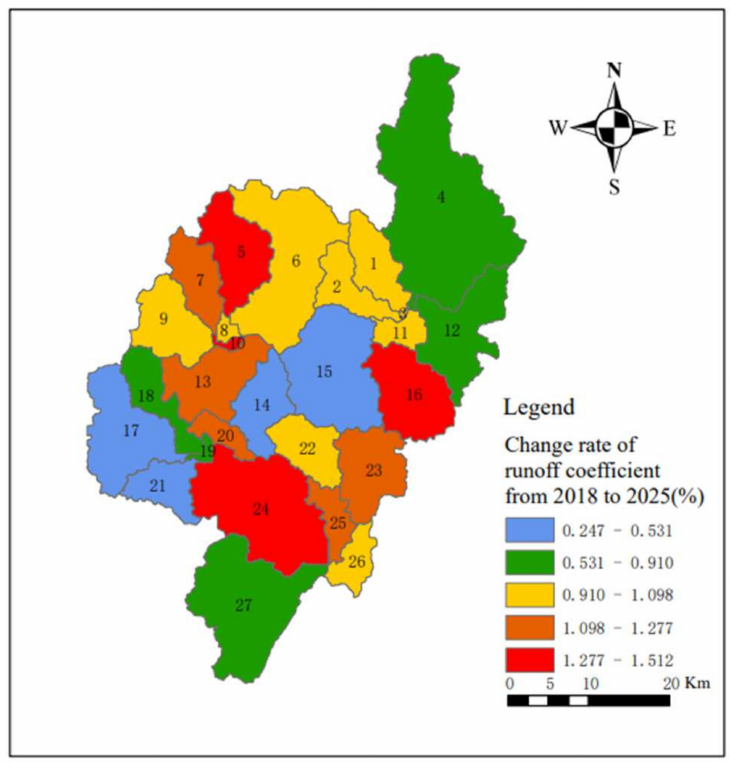
Figure 10. Runoff coefficient variation map from 2018 to